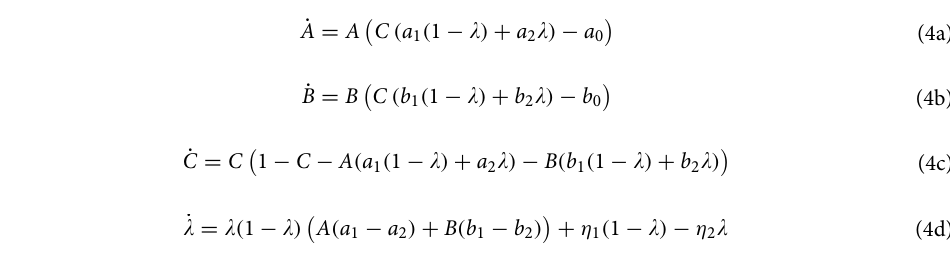
transformation and rescaling of variables (described in “Methods”), the new dynamical system can be written as: